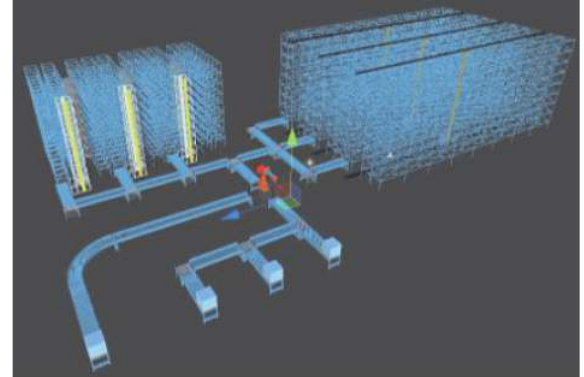
Fig. 5 Warehouse logistics scenario generated from parameterized information.